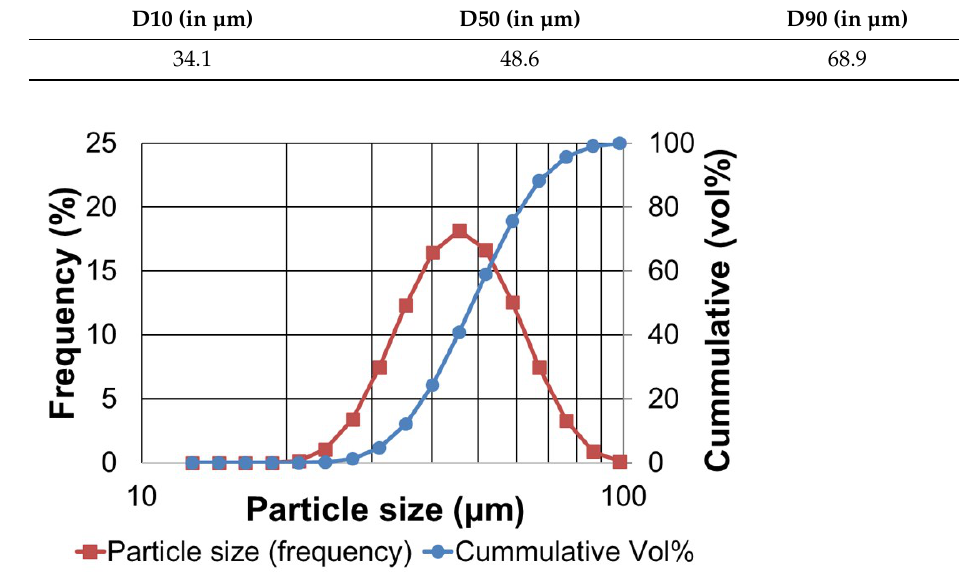
Figure 1. Powder size distribution of Al-Mg-Sc-Zr powder. Table 2. Chemical composition for Al-Mg-Sc-Zr (Scalmalloy ® ) alloy in as-received powder form and as-printed